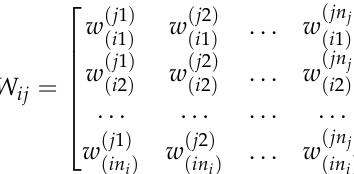
Figure 5. ANP Hierarchy.